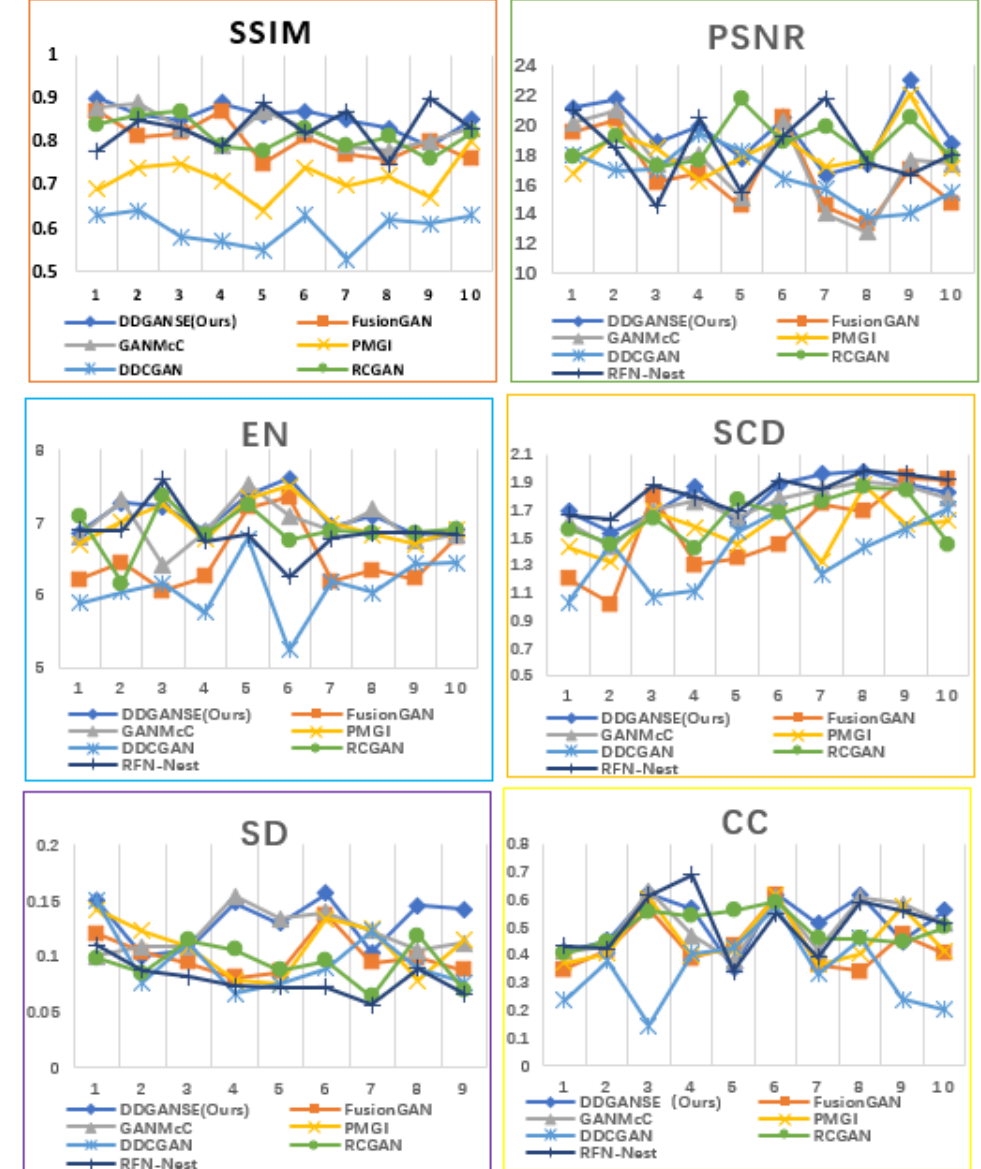
Figure 9. Line charts of the quantitative results for six indicators of infrared and visible image fusion. Table 2. Quantification results for our proposed method and state-of-art fusion methods (the best value is marked in yellow, and the second-best value is marked in red).